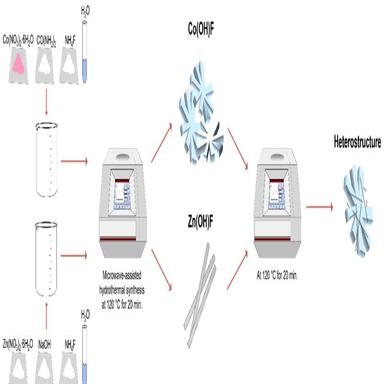
Illustration of the synthesis process of Co(OH)F, Zn(OH)F, and heterostructure materials.